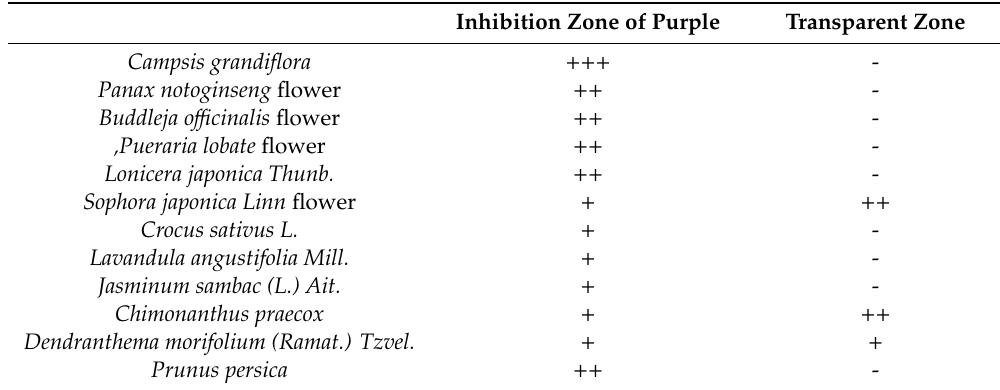
Table 1. Screening results of 38 kinds of plant flowers used for Chinese herbs.